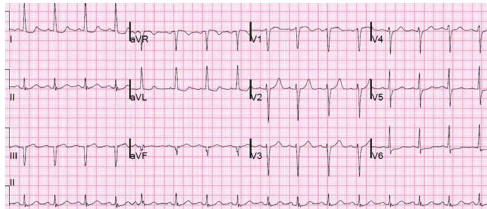
Figure 1: Electrocardiogram showed sinus tachycardia, evidence of old inferior and anterior infarct, left ventricular hypertrophy, and nonspecific lateral ST abnormalities.